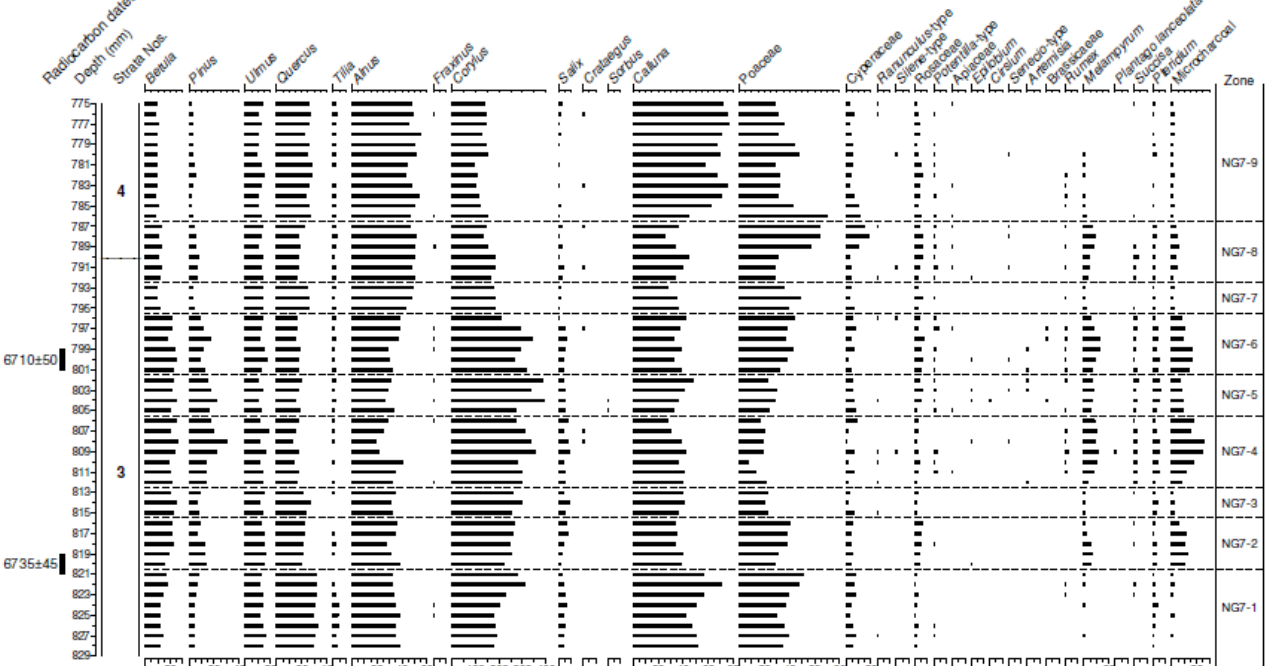
Figure 4. Selected taxa pollen diagram through a Mesolithic age disturbance phase at North Gill 7. Frequencies are calculated as percentages of total tree pollen, which comprises Betula to Fraxinus in the diagram.